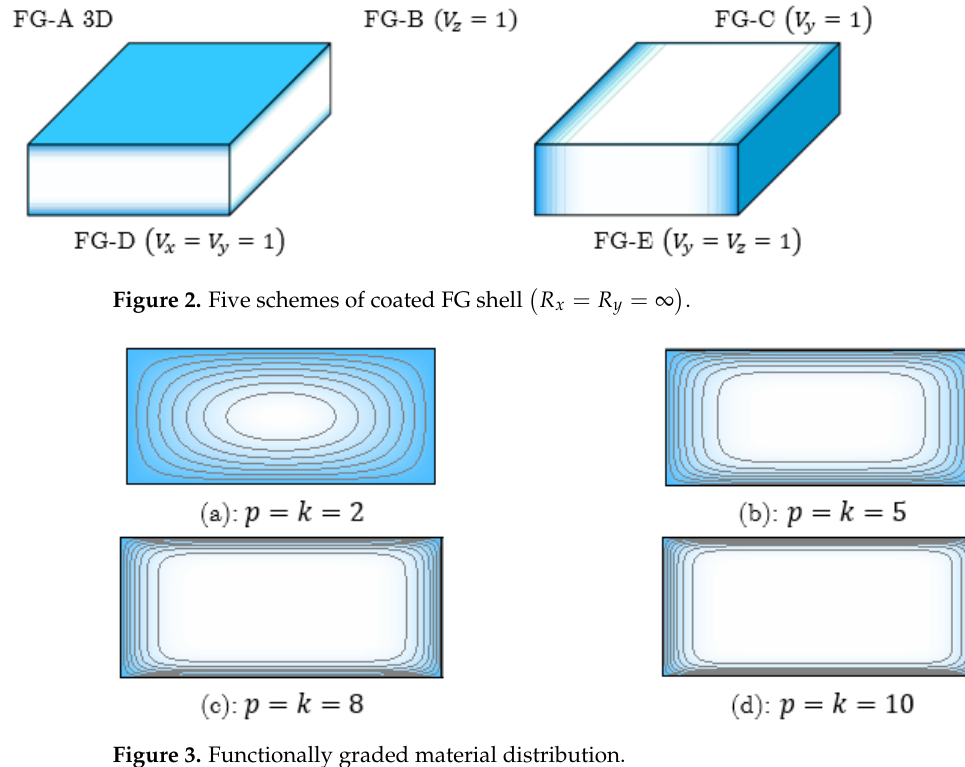
Figure 3. Functionally graded material distribution.